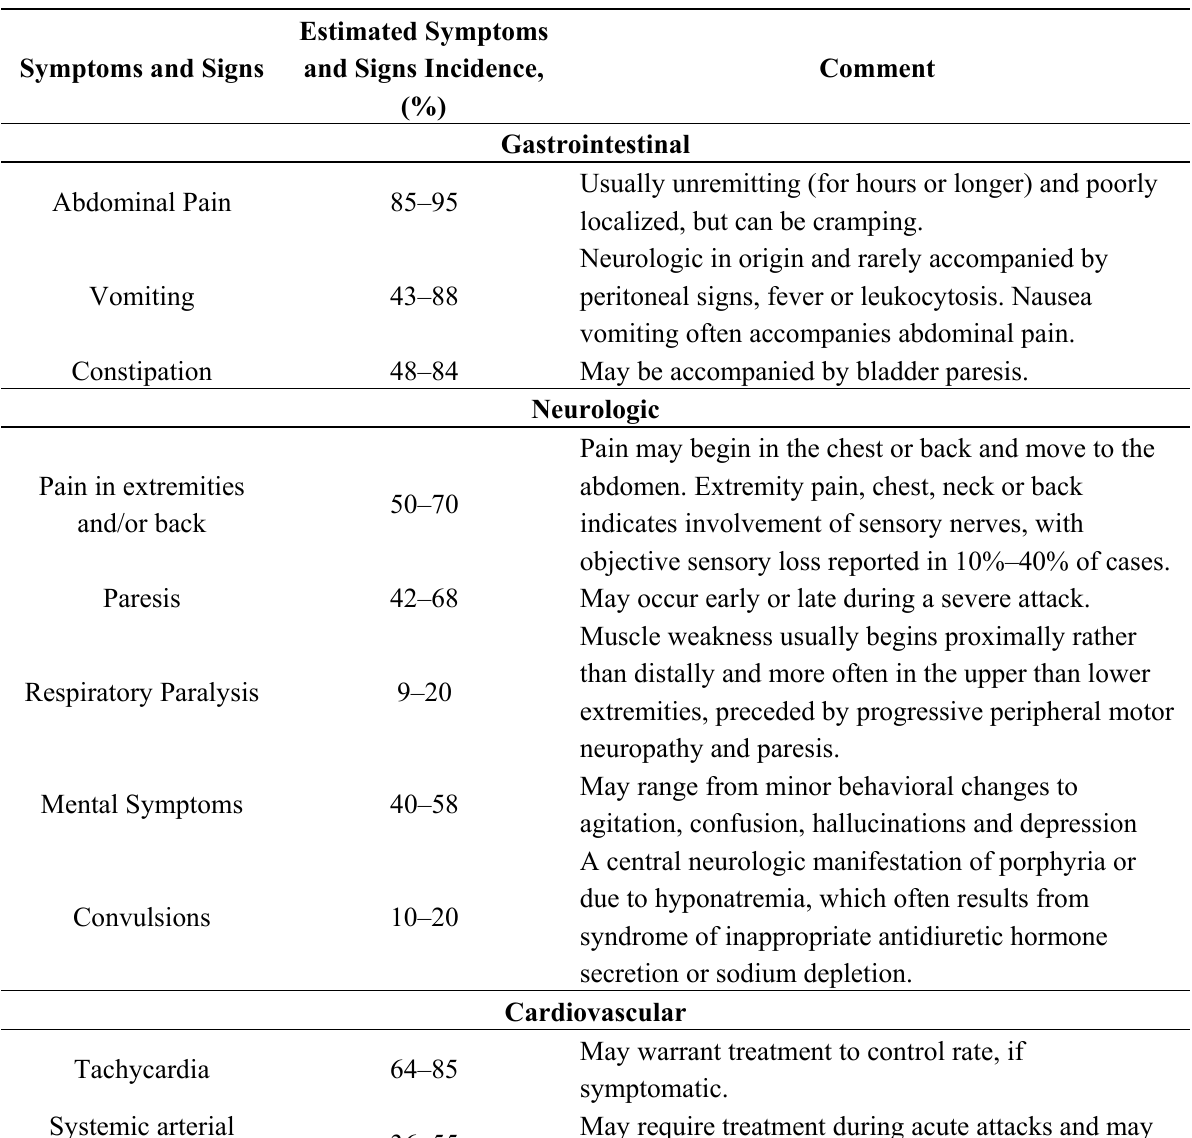
Table 4. Common presenting symptoms and signs of acute porphyric